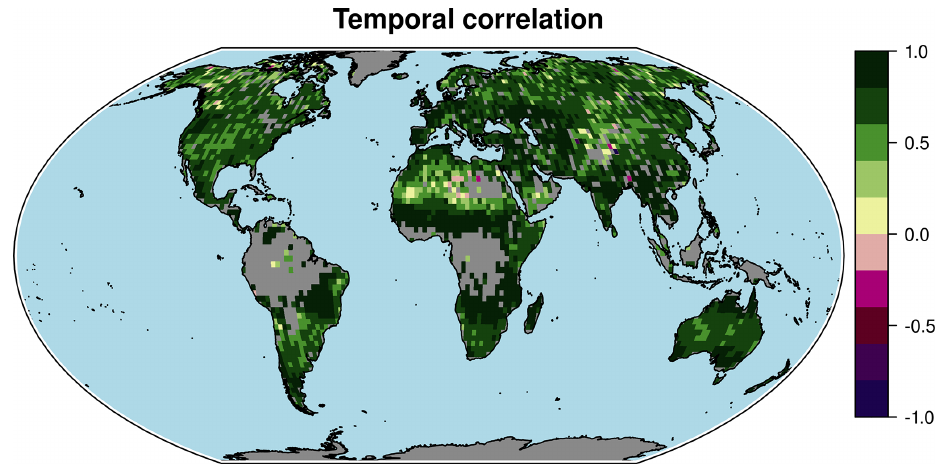
Figure 4. Correlation coefficient of the observed and predicted volumetric soil moisture time series in the individual grid cells during the test years 2014 and 2015. In the grey regions no observations are available during the this